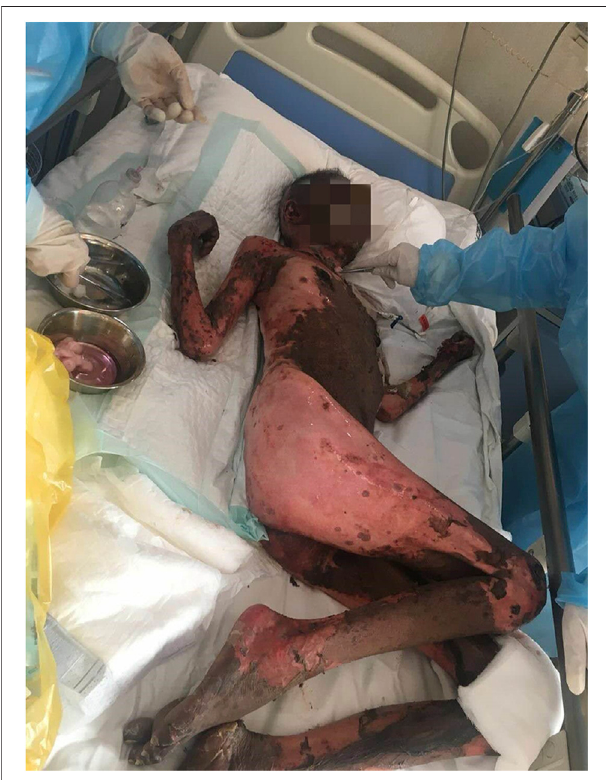
FIGURE 3 | A large exfoliated area of the body (BSA more than